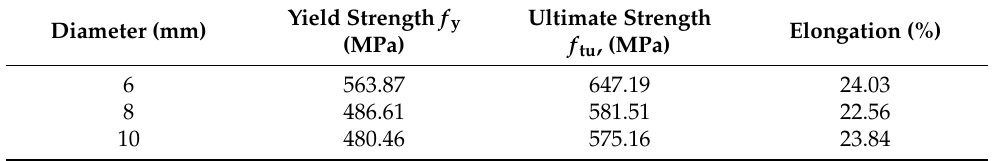
Table 3. Material properties of steel bars.